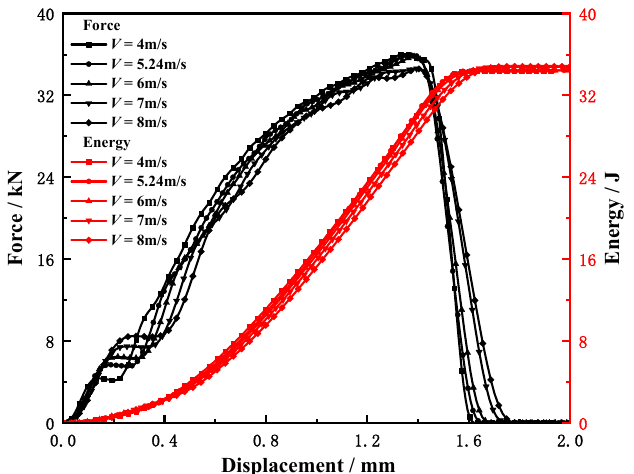
Figure 15. Influence of striker velocity on the load–displacement and energy–displacement curves.